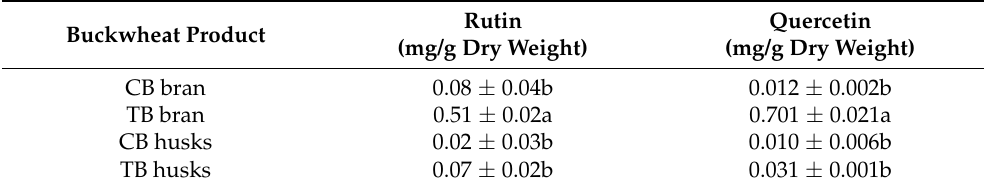
Table 2. Rutin and quercetin concentrations (average ± SD) in common buckwheat (CB) and Tartary buckwheat (TB) bran and husks. Different letters mark statistically significantly different results, according to the Tukey HSD test ( p ≤